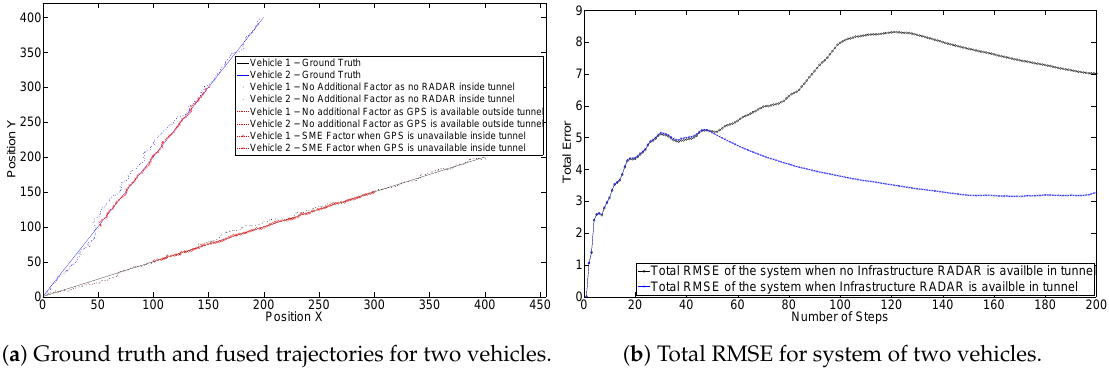
Figure 11. Simulation of two vehicles through the tunnel, demonstrating the use of SME factor using online iSAM2